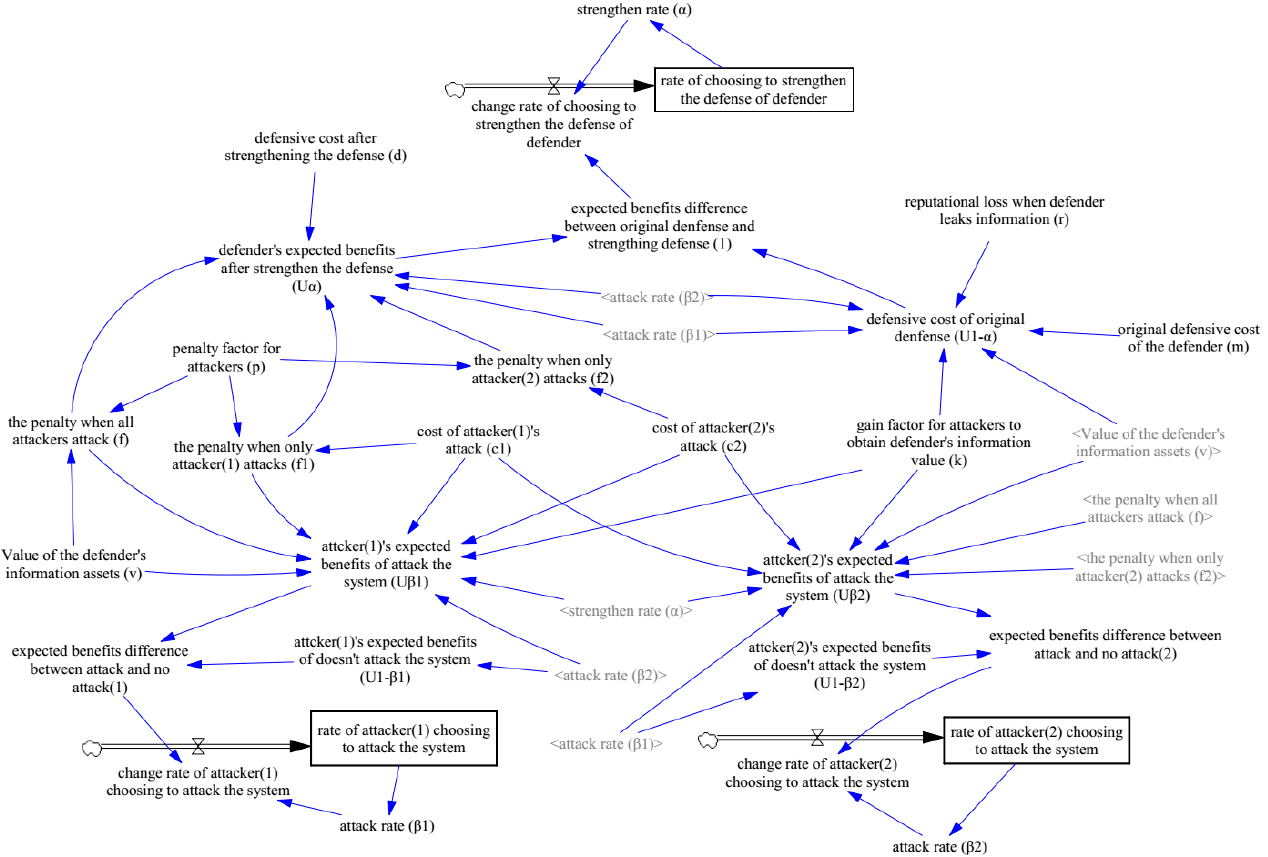
Figure 3. Evolutionary game system dynamics (SD) model of network attack and defense. The basic parameters of the model are set as follows: INITIAL TIME = 0, FINAL TIME = 50, TIME STEP = 0.25, Integration Type: Euler. The initial values of the exogenous variables in the SD model are shown in Table